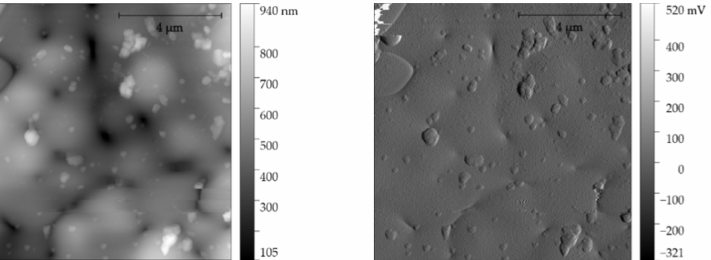
Figure 8. AFM image of height (topography) and signal error of large grain with overlap (captured at grain ripple).